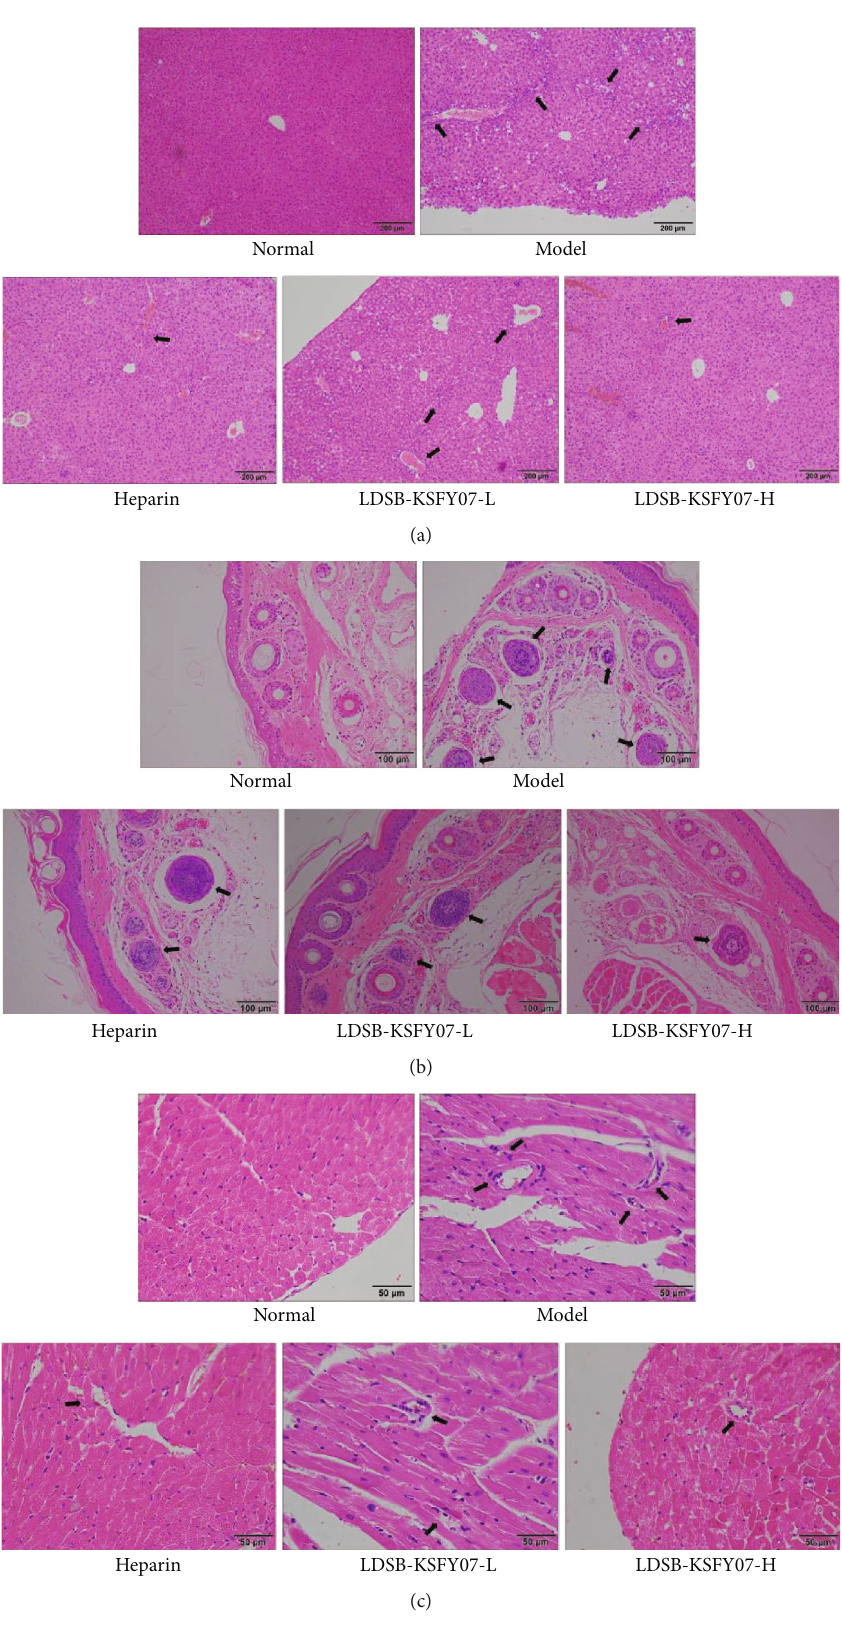
Figure 2: Pathological observation of liver (a), tail (b), and cardiac (c) tissues in mice with kappa-carrageenan-induced thrombosis. The arrow indicates the site of tissue